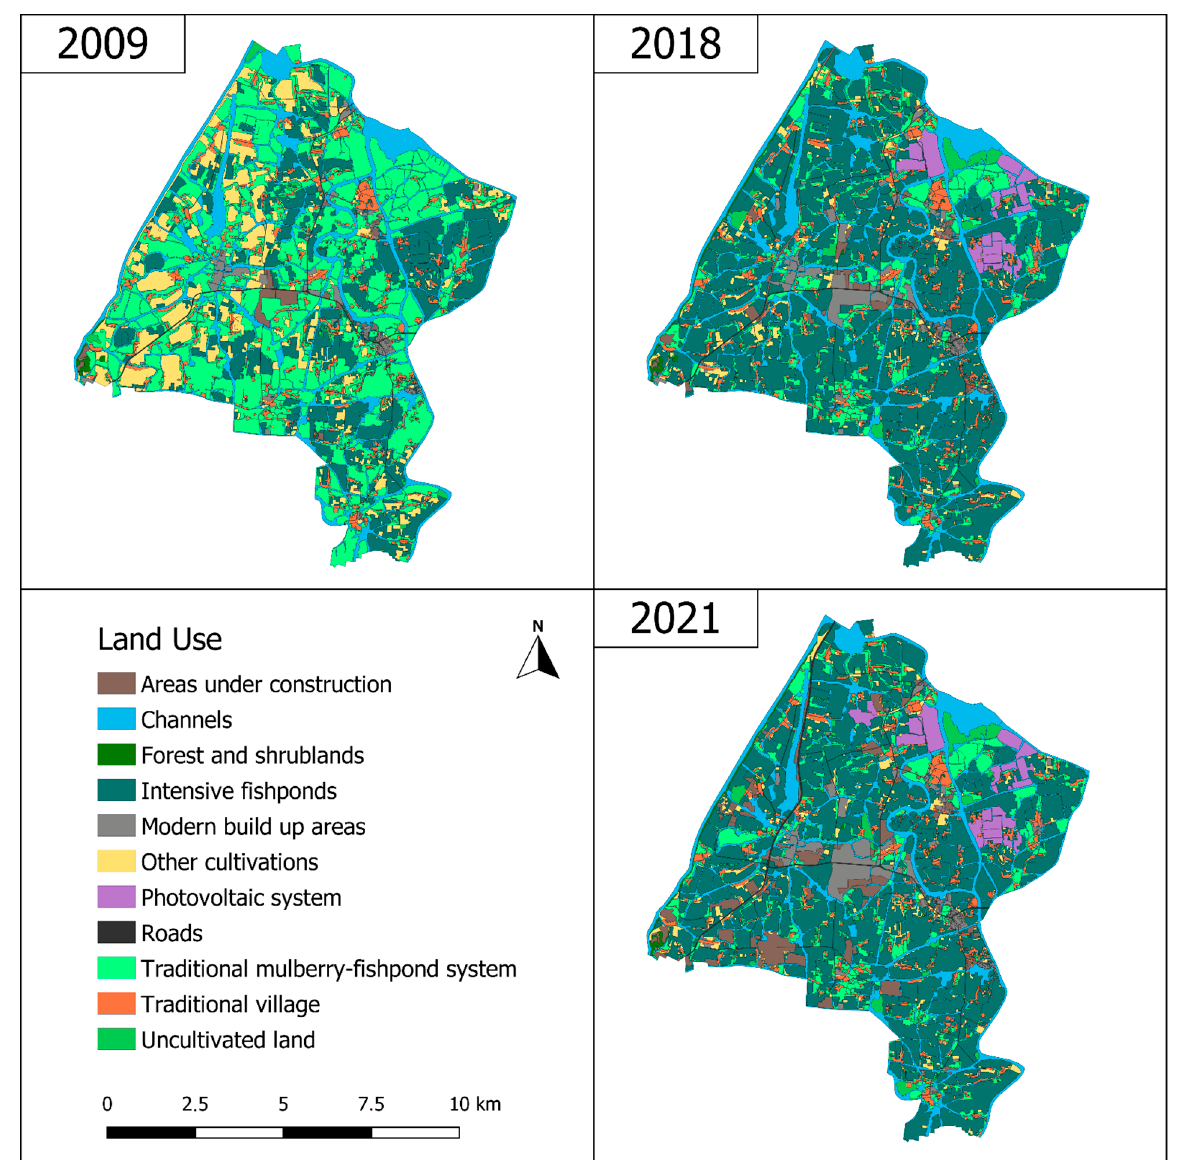
Figure 4. Land use maps of the MFS GIAHS site for the years 2009, 2018, and 2021. Table 3. Surface in hectares and percentages occupied by the different land uses in 2009, 2018, and 2021.